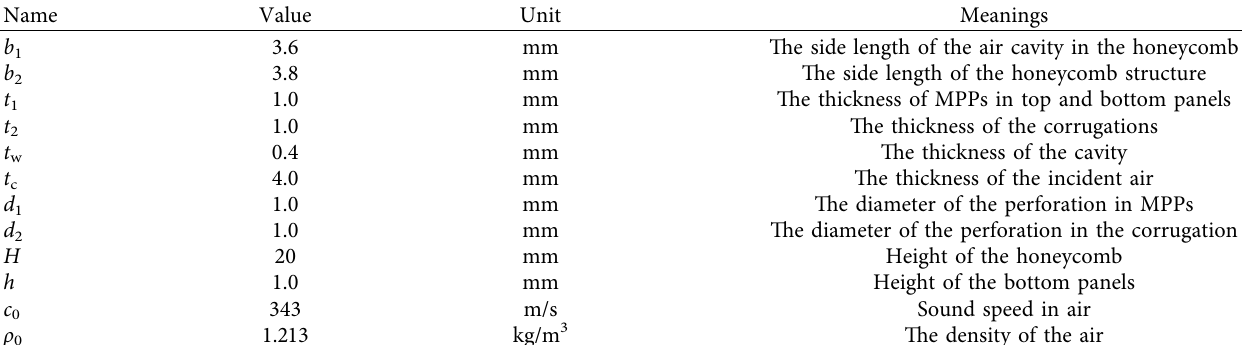
Table 1: Geometry parameters.